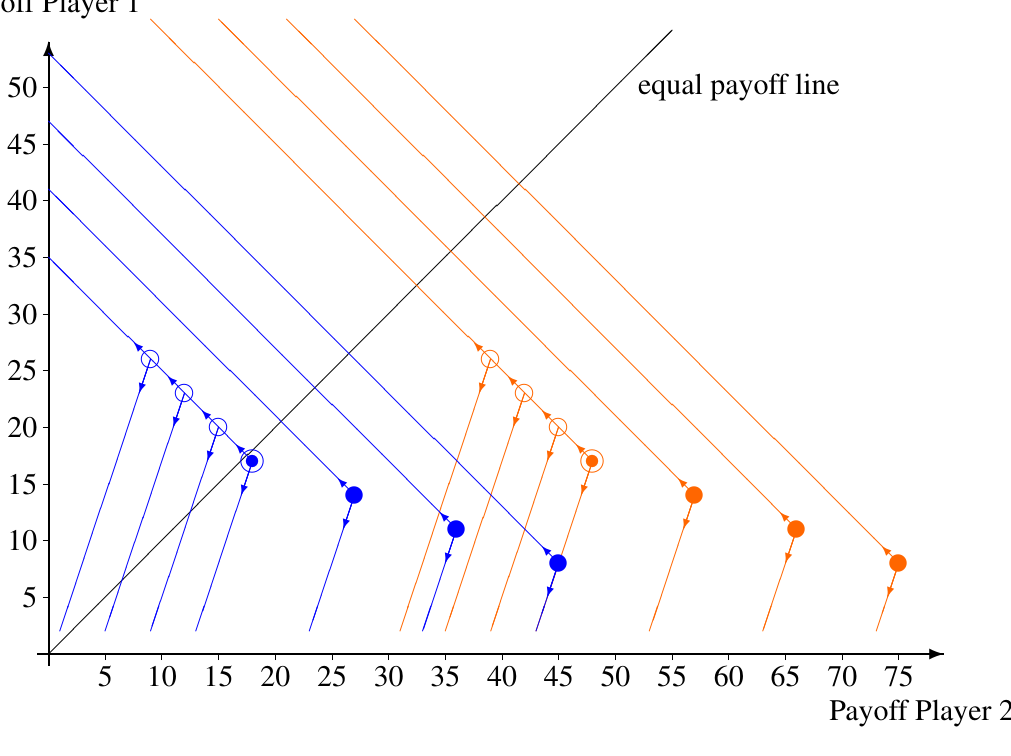
Figure 1 . Strategy space of the game (blue for Treatment 1 and orange for Treatment 2). The emphasized circles denote the status quo payoff distribution. Player 1 may move to another distribution by taking (empty circle of same color) or sending money (filled circle of same color). Player 2 may punish or reward by moving along the corresponding lines in the indicated